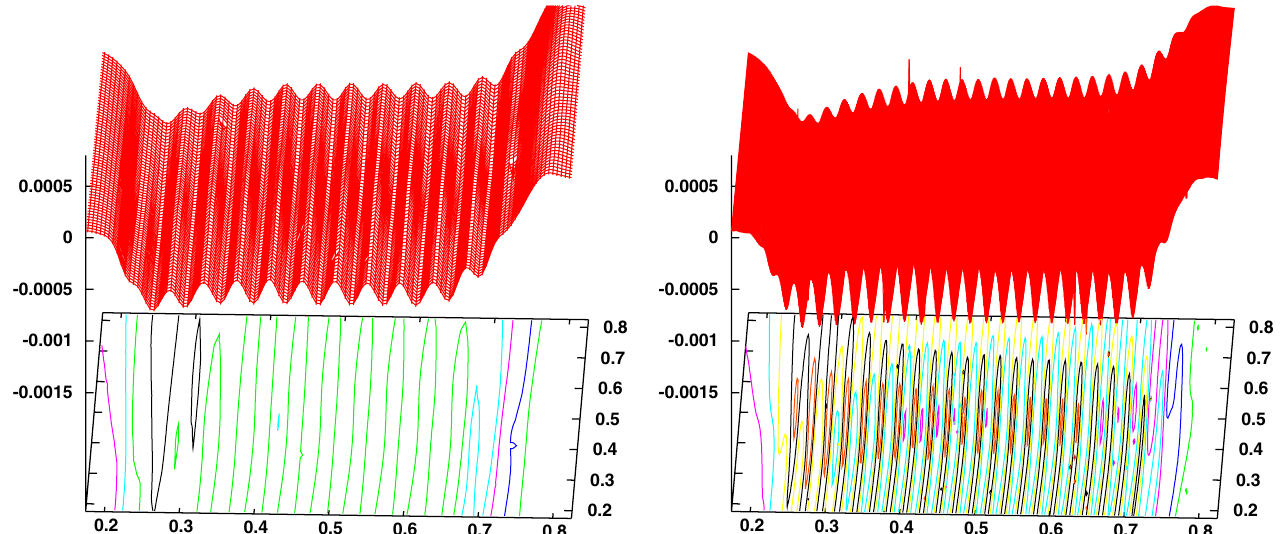
Þ at s ¼ s ¼ 200 (cid:4) m (left) and (cid:2) ; x for (cid:2) f 1 2 0